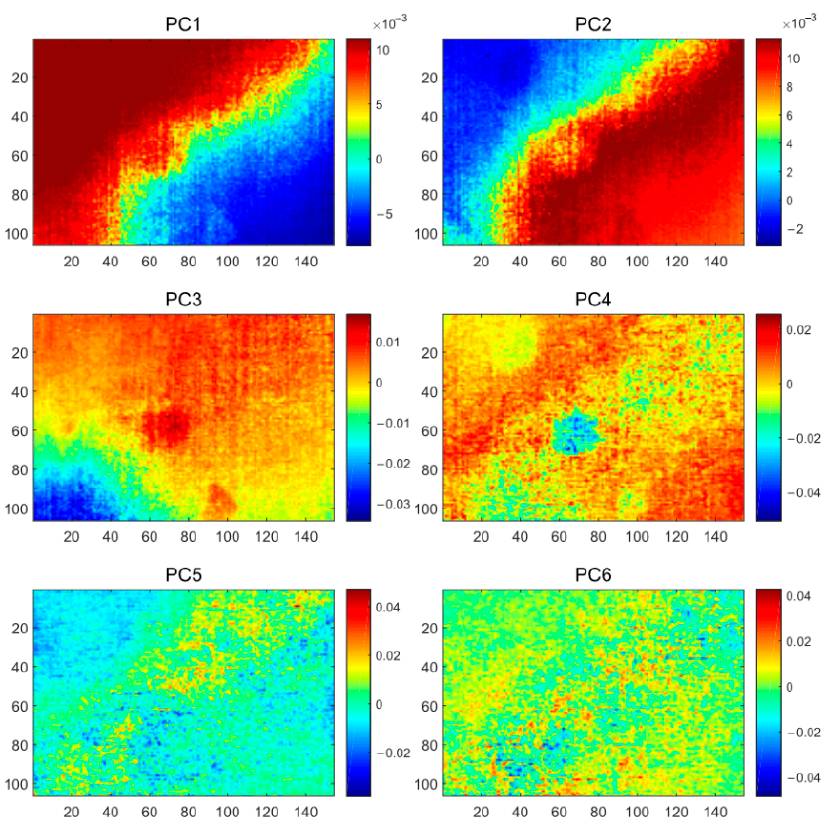
Figure 8. The GPCT analysis results of the CFRP specimen 1. KPCT, application of the kernel PCA algorithm to thermography. The value of the Gaussian kernel width was chosen to be 1.4 in the execution of the algorithm. By mapping the nonlinearly indistinguishable thermographic data into a high-dimensional space, it can be linearly separable. In doing so, the performance of KPCT is usually improved over PCT (besides the identification of diamond-shaped defects), which has a stronger ability to extract defect information. Figure 9 shows the first six PC images obtained by